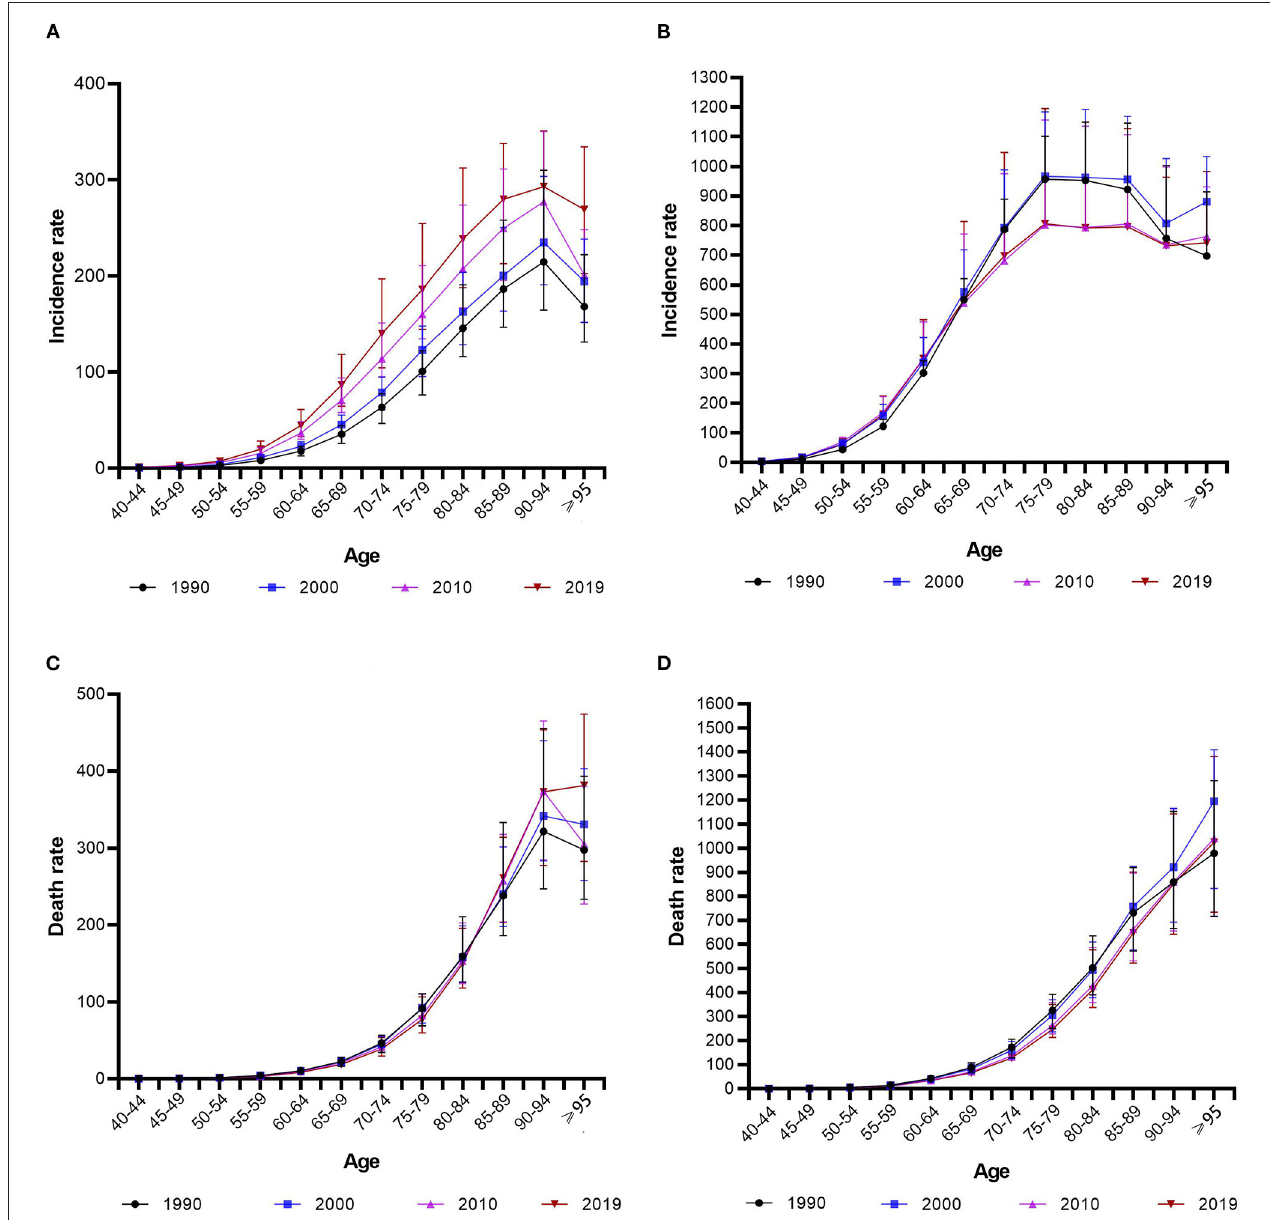
FIGURE 3 | The incidence and mortality rates of protate cancer of different age groups for China [ (A) incidence rate; (C) mortality rate] and the USA [ (B) incidence rate; (D) mortality rate] in 1990, 2000, 2010, and 2019.